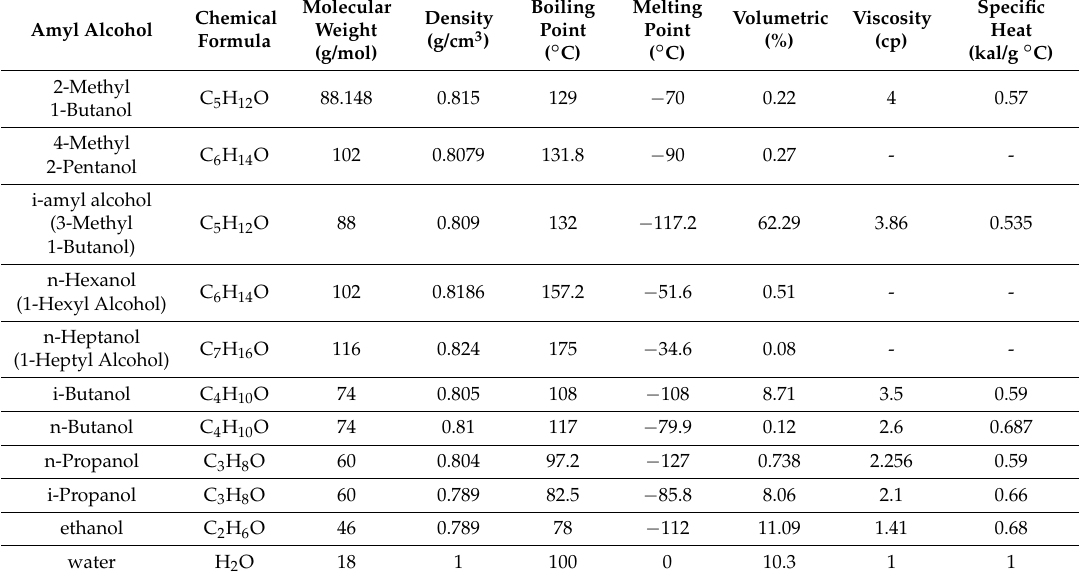
Table 1. Characteristics of fusel oil